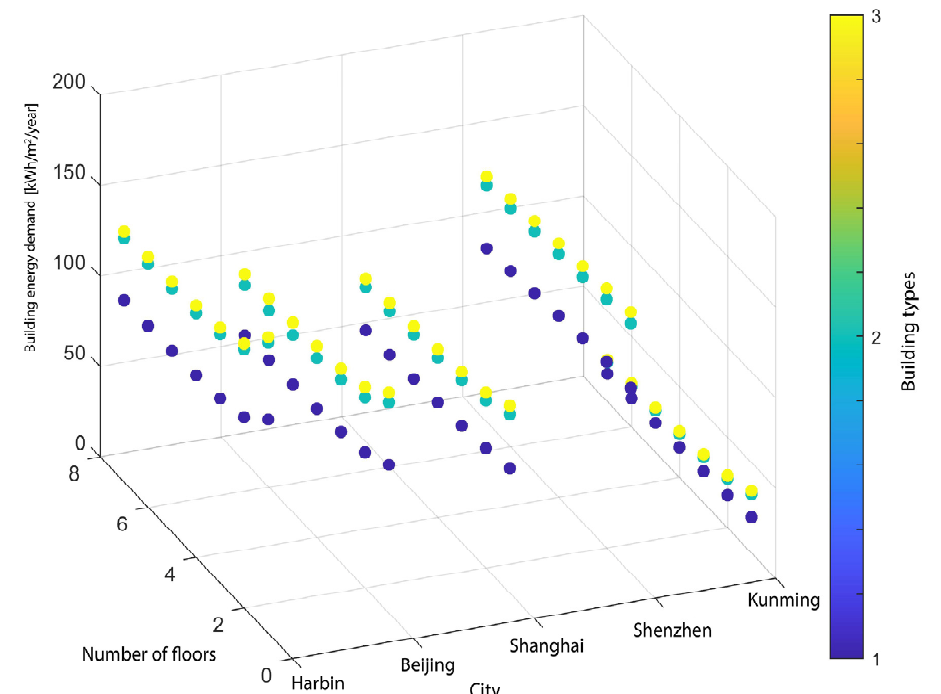
Figure 26. Relationship between the number of floors and the building energy demand.